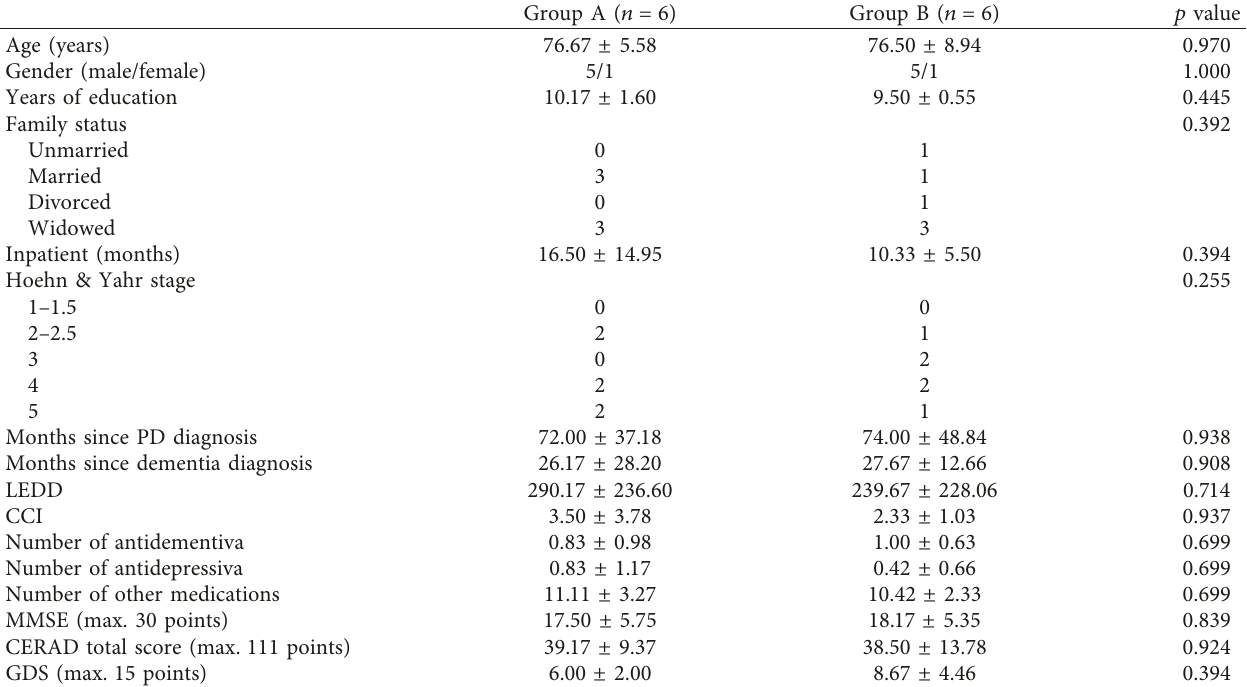
Table 1: Baseline sociodemographic and clinical characteristics of the study